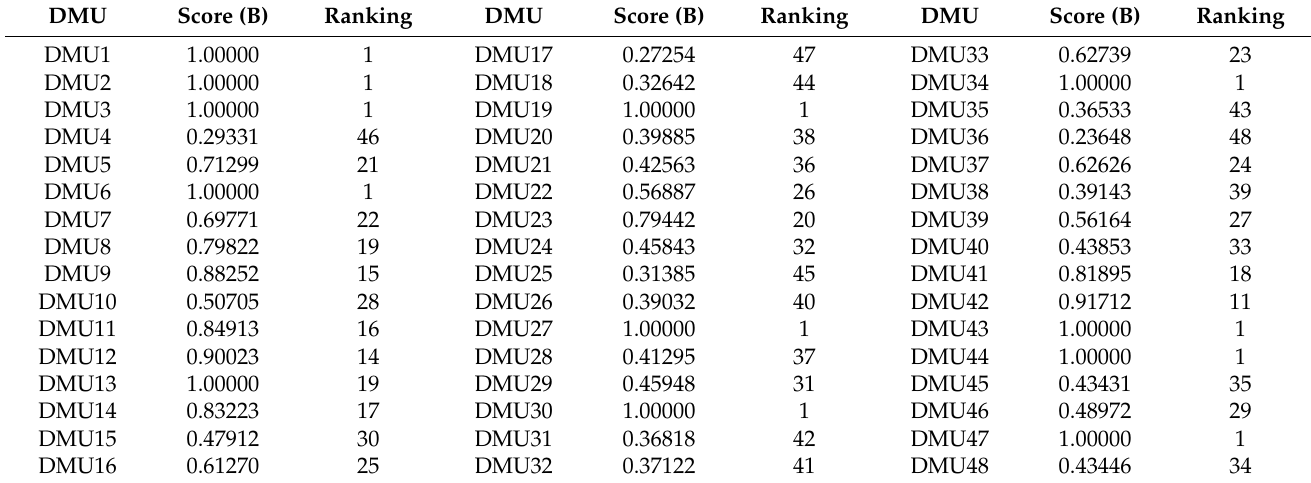
Table 3. Score and ranking of DMUs in the research sample, according to the